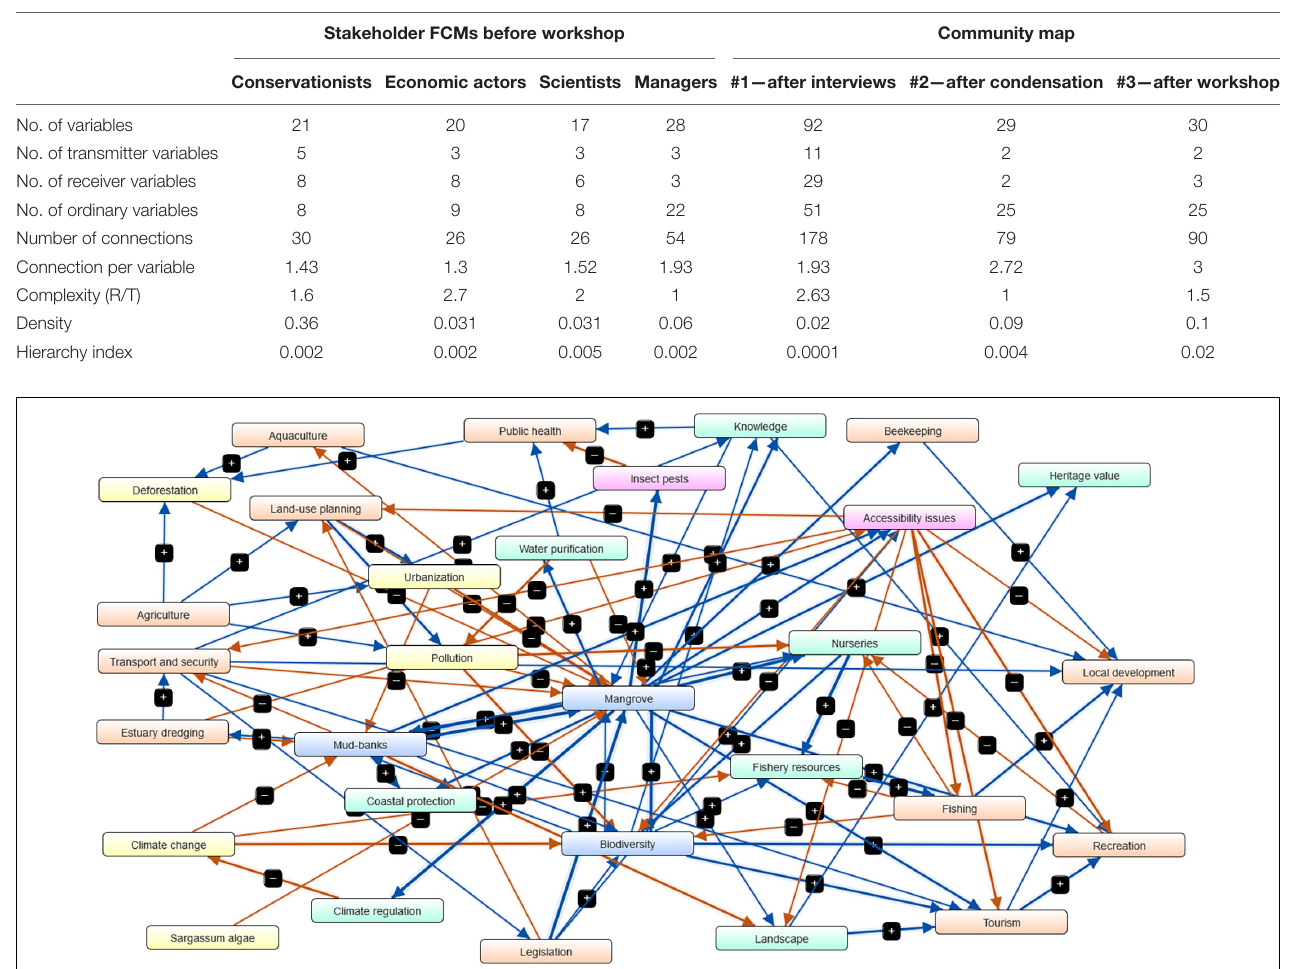
FIGURE 1 | Community map after workshop [Blue arrows (with a “+” sign) indicate a positive relationship, while orange (with a “-” sign) indicate a negative relationship. Thickness of the arrow reflects the strength of the relationship from | 1| (when reported by every group) to | 0.25| (when reported by only one group). Box colors are selected to assist the reading of the FCM: Blue boxes for biological compartments, green boxes for ecosystem services, pink boxes for disservices, orange boxes for anthropic activities and yellow boxes for pressure vectors].